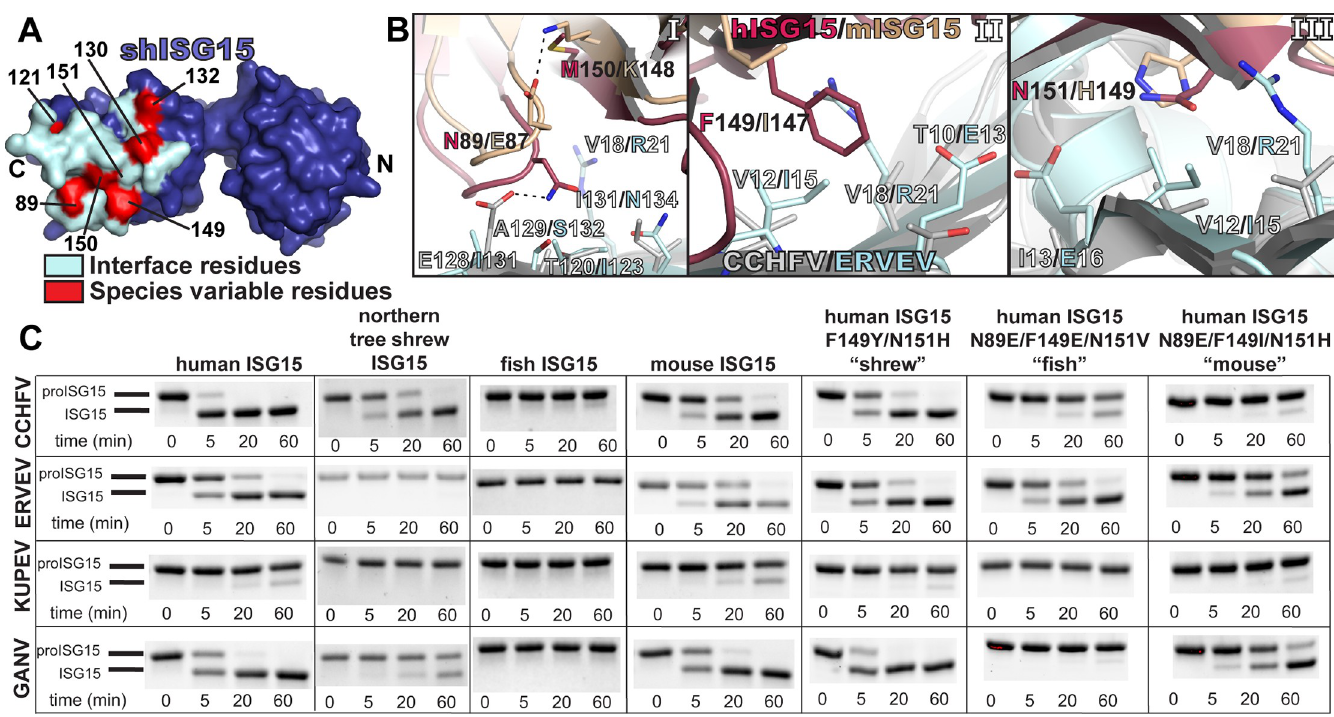
Fig 6. Molecular contributors to species-variable ISG15 interactions with nairovirus OTUs. (A) Surface rendering of sheep ISG15 (purple) with the residues forming the interface shown in light teal. The locations of residues 89, 149, and 151 that have been previously suggested as responsible for species-specific interactions are indicated. (B) Molecular environment of the CCHFV OTU-human ISG15 (PDB ID 3PHX) and ERVEV OTU-mouse ISG15 (PDB ID 5JZE) structures surrounding residues 89 and 149–151 (87 and 147–149 in mouse ISG15). (C) Cleavage assays of the CCHFV, ERVEV, KUPEV, and GANV OTUs with mutant human proISG15 constructs. Mutations were introduced to human proISG15 at residues 89, 149, and 151 to match those in northern tree shrew, fish, or mouse ISG15. Samples from each timepoint were run on BioRad Mini-PROTEAN 1 TGX Stain-Free ™ gels and visualized as described in the Materials and Methods.